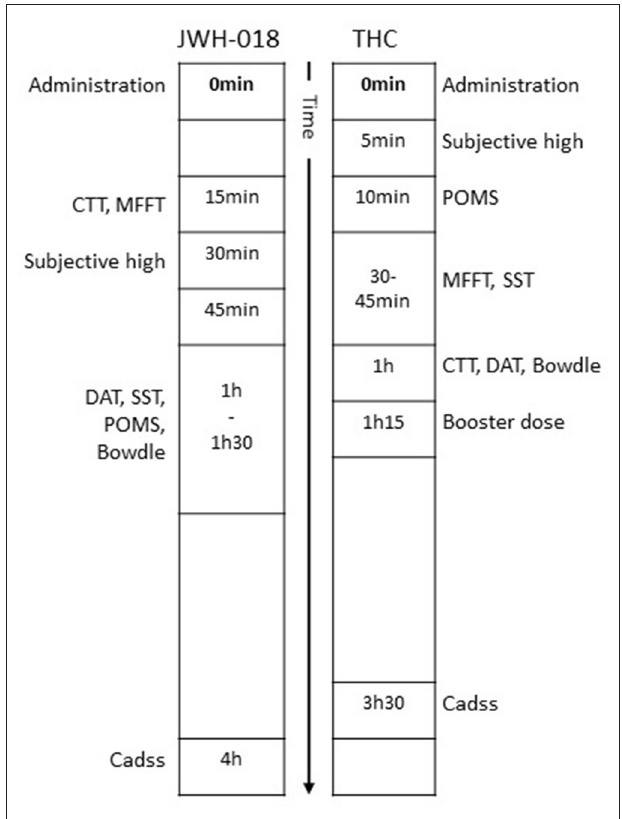
FIGURE 1 | Timeline of subjective questionnaires and cognitive tests relative to time of drug